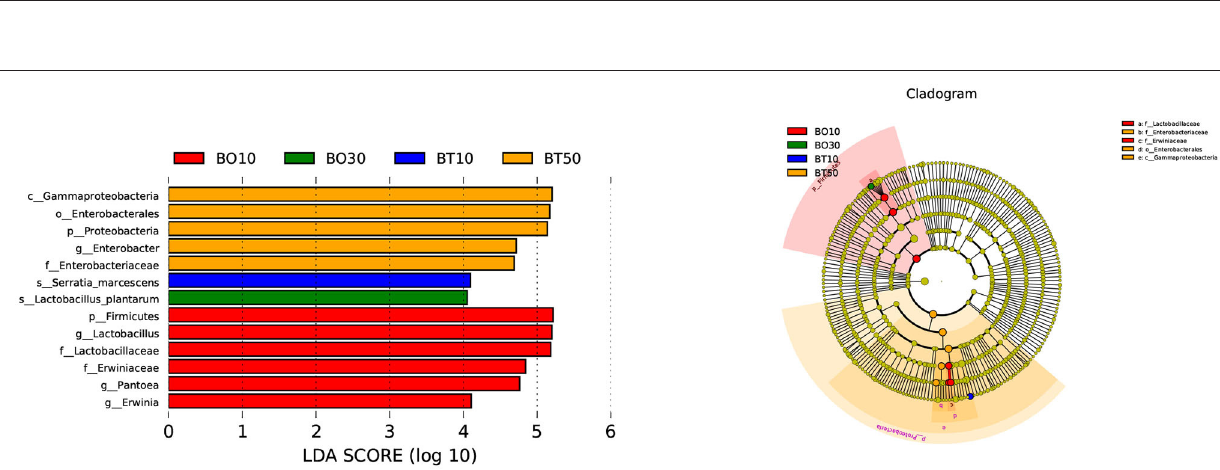
within the acceptable range of 10% NH 3 -N/TN (McDonald et